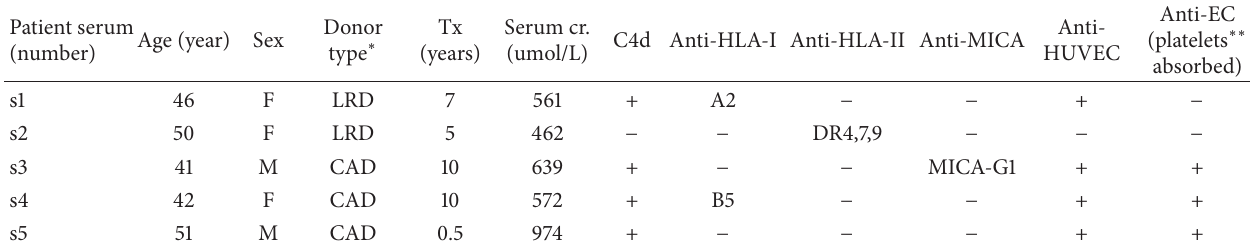
Table 1: Characteristics of selected sera from patients with kidney allografts undergoing rejection. Patient